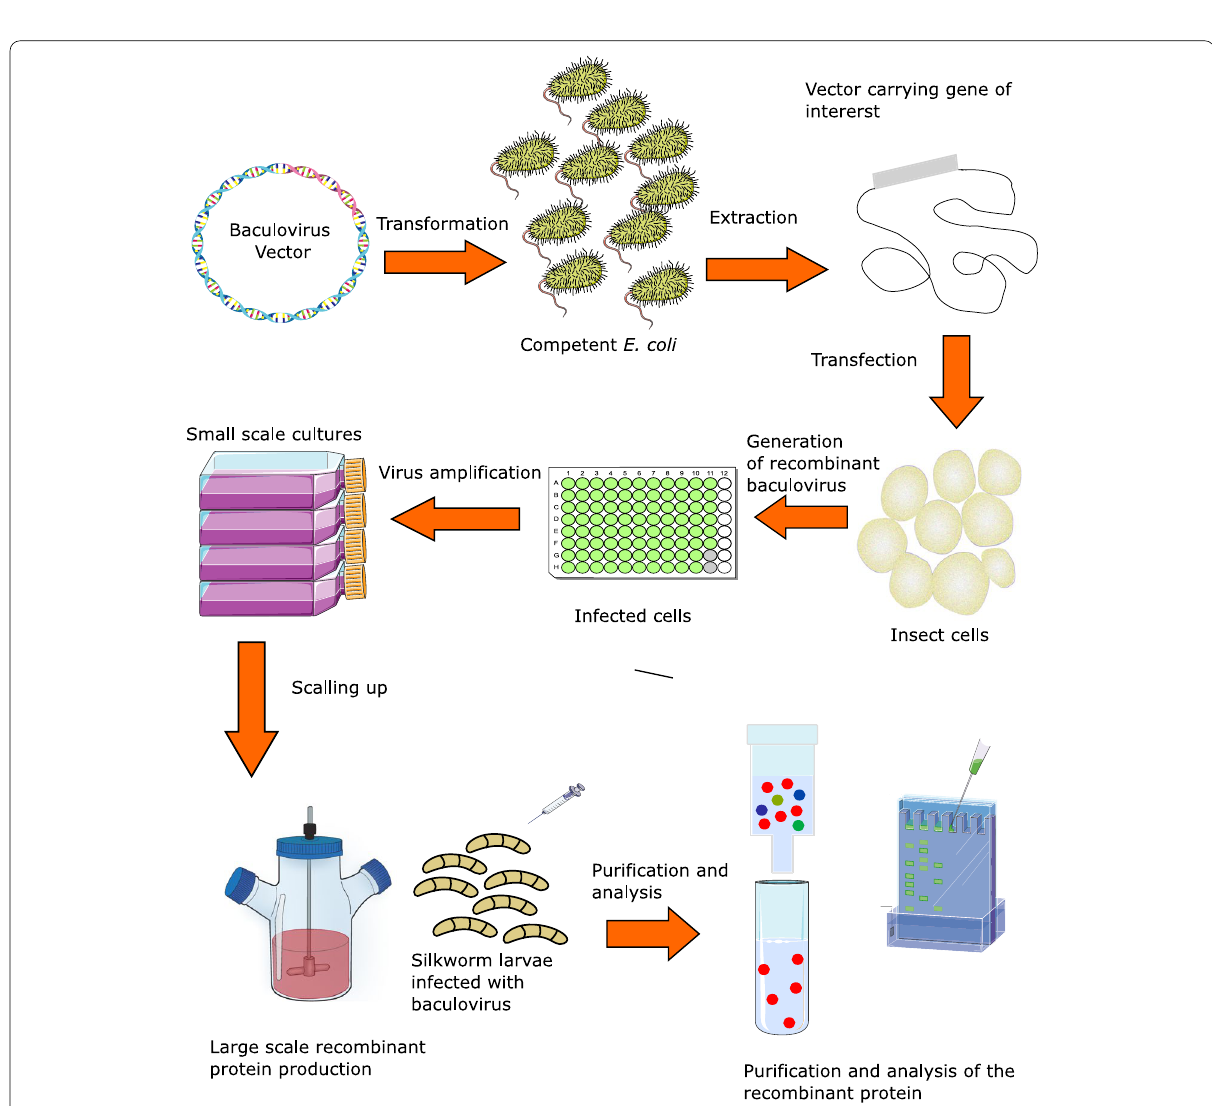
Fig. 1 An overview of the general process for SAR-CoV-2 protein production in BEV. A baculovirus vector encoding the SARS-CoV-2 protein is transformed into competent E. coli . Translocation occurred in E. coli where the gene encoding SARS-CoV-2 protein was transferred from the donor plasmid to the bacmid. The bacmid is extracted from E. coli and used to transfect insect cells for the generation of recombinant baculoviruses. The recombinant baculovirus is further amplified for up scaling of the recombinant protein production. High-scale protein production is produced in bioreactors or by silkworm larvae. The protein is purified and analyzed before being used for various